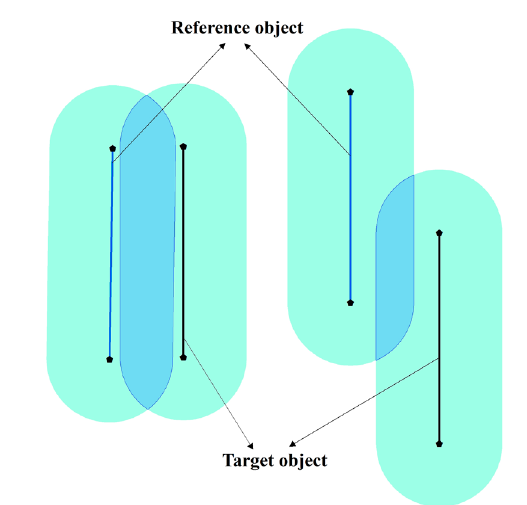
Fig. 4. Buffer overlay region of two linear